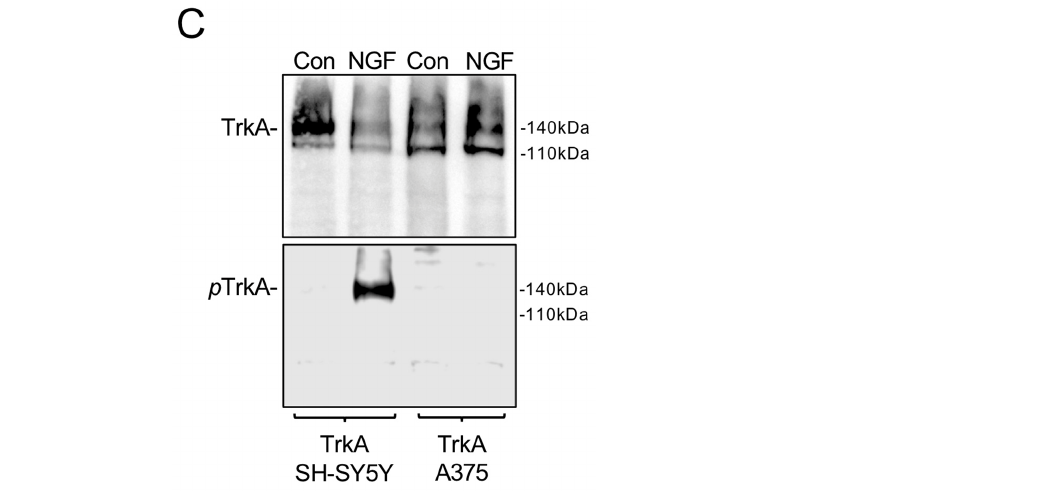
Figure 5. DTT augments TrkAIII and Akt phosphorylation in A375 transfectants. ( A ) Micrographs demonstrating immunoreactivity to mouse monoclonal anti-TrkA (B3) antibody (orange) but not to rabbit monoclonal anti-pY490-phosphorylated TrkA antibody (green, pTrkA) in untreated DTT- treated transient fully spliced TrkA A375 transfectants (bar = 50 μm). The Western blots demonstrate changes in fully spliced TrkA maturation, without phosphorylation (pTrkA), and no change in Akt and phosphorylated Akt (pAkt) levels in fully spliced TrkA A375 extracts, following DTT treatment in the absence (DTT) and presence of lestaurtinib (DTT/Lest) (50 μg loads). The histogram demonstrates the lack of DTT effect on Akt phosphorylation following DTT treatment in the absence or presence of lestaurtinib, in fully spliced TrkA A375 extracts (50 μg loads), expressed as mean ± s.e. fold increase in phosphorylation compared to untreated controls (1 fold), in 3 independent experiments; ( B ) micrographs demonstrating TrkAIII immunoreactivity to mouse monoclonal anti- TrkA (B3) antibody (orange), phosphorylated TrkAIII immunoreactivity to rabbit monoclonal anti- pY490-phosphorylated TrkA antibody (green, pTrkA), overlapping immunoreactivity (yellow) and DAPI-stained nuclei (blue) in untreated TrkAIII A375 transfectants (upper panels) and augmented phosphorylated TrkAIII immunoreactivity following DTT treatment (middle panels, green/yellow) and absence of phosphorylated TrkAIII immunoreactivity (pTrkAIII) following co-treatment with DTT and lestaurtinib (DTT/Lest) (lower panels) (bar = 50 μm). The Western blots demonstrate augmented phosphorylated TrkAIII (pTrkAIII) levels in TrkAIII A375 transfectants following DTT treatment in the absence (DTT) but not in the presence of lestaurtinib (DTT/Lest), compared to untreated controls (Con) (50 μg loads) (left panels), and augmented Akt phosphorylation (pAkt) in TrkAIII A375 transfectants treated with DTT in the absence (DTT) but not in the presence of lestaurtinib (DTT/Lest), compared to untreated controls (Con) (50 μg loads). Histograms display significant increases (*) in TrkAIII and Akt phosphorylation following DTT treatment in the absence (DTT) but not presence of lestaurtinib (DTT/Lest), expressed as the densitometric mean ± s.e. fold increase in phosphorylation, compared to untreated controls (1 fold), in 3 independent experiments. In all experiments, DTT was used at a concentration of 50 mM and lestaurtinib at 100 nM, and the treatment duration was 6 h. Magnifications of boxed areas are also provided to the left of each micrograph to determine expression in more detail. ( C ) Western blots demonstrating NGF (100 ng for 15 min) induction of fully spliced TrkA phosphorylation in SH-SY5Y transfectants (20 μg loads) but not in fully spliced TrkA A375 transfectants (50 μg loads). These data demonstrate that DTT induces TrkAIII but not fully spliced TrkA phosphorylation in transient A375 melanoma cell transfectants. The data also demonstrate that DTT-induced TrkAIII phosphorylation is prevented by lestaurtinib, and that fully spliced TrkA is not activated by NGF in transient A375 transfectants.